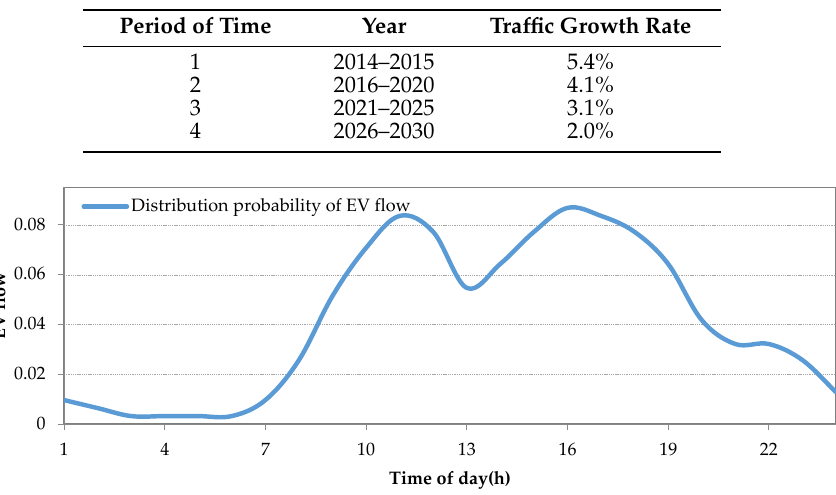
Table 1. Gasoline traffic growth rate in the future.